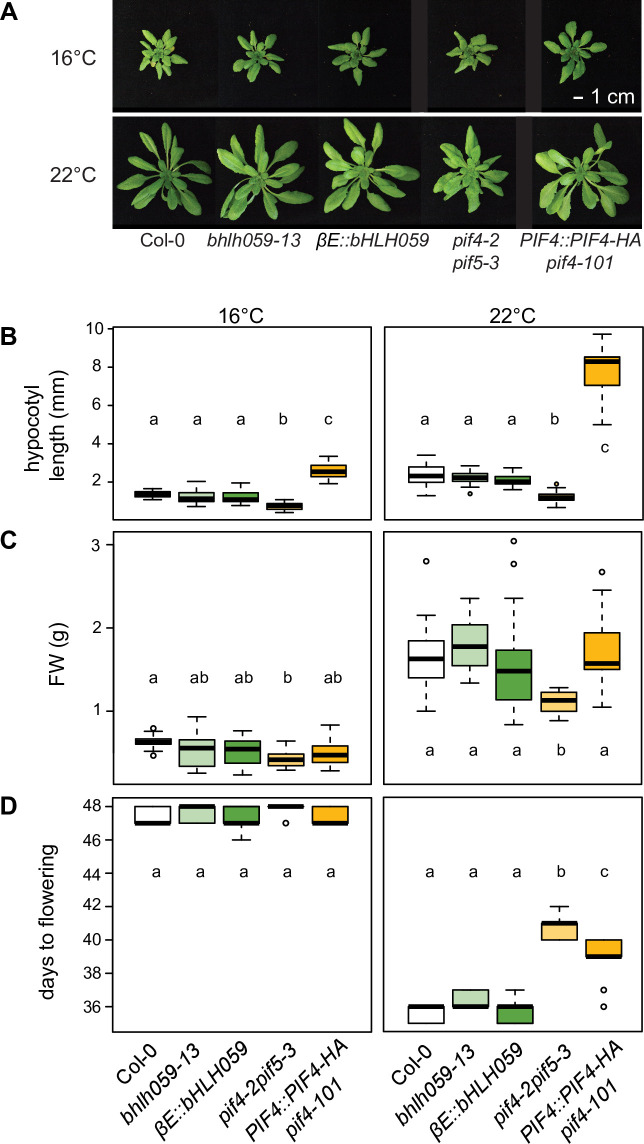
Comparing developmental phenotypes of Col-0 (white), bHLH059 (green) and PIF4 lines (orange), as indicated, grown at 16°C or 22°C.Letters represent significant differences between genotypes after Tukey’s multiple testing correction in one-way ANOVA. A) Visual phenotypes of 5-week-old plants. B) Hypocotyl lengths of seedlings 10 d after germination (n = 15 from three biological replicates). C) Above-ground fresh weights of 5-week-old plants (n = 12 from three biological replicates). D) Days to flowering (n = 9 from three biological replicates).